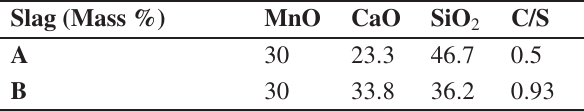
Table 1. Slag compositions studied.